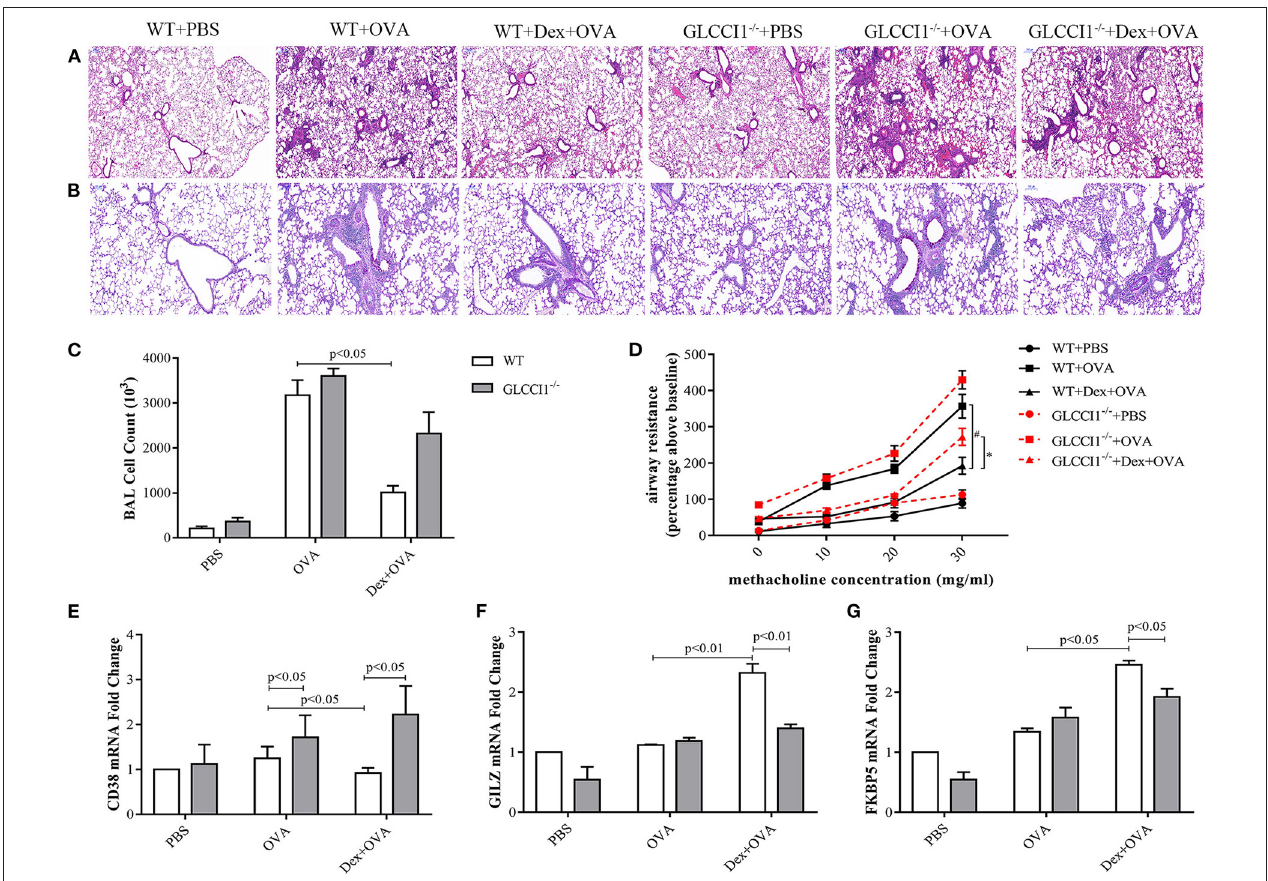
FIGURE 1 | GLCCI1 deficiency leads to glucocorticoid insensitivity in OVA-induced asthmatic mice. (A) Representative H&E staining images (100 × ). (B) Representative PAS staining images (200 × ). (C) Whole BALF cell numbers in different groups. (D) Airway resistance detection. Result expressed as the airway resistance (percentage above baseline) indicating ratio with saline exposure. (E–G) RT-PCR analysis of CD38 (E) , GILZ (F) , and FKBP5 (G) mRNA expression in lung tissues. Results are presented as the mean ± SEM, n = 6 mice per group. * P < 0.05, # P < 0.05. Intergroup differences as determined one-way ANOVA followed by LSD